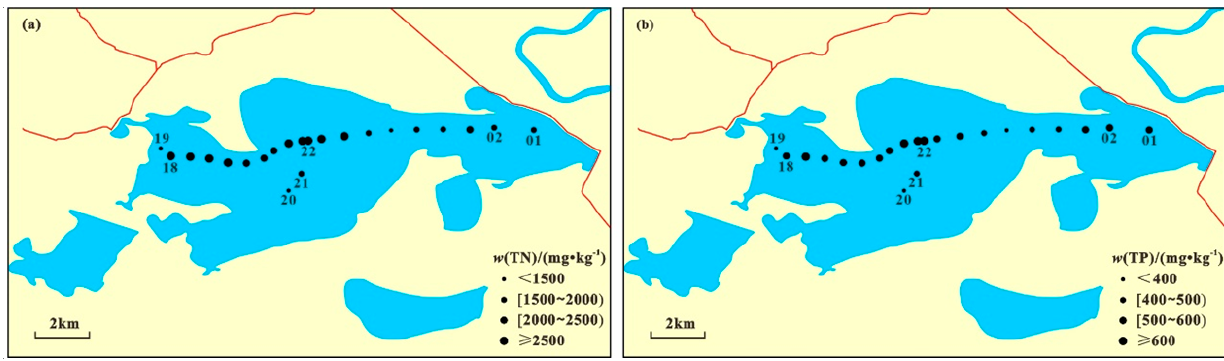
Figure 2. Distribution of TN ( a ) and TP ( b ) in surface sediments of Yueliang Lake.